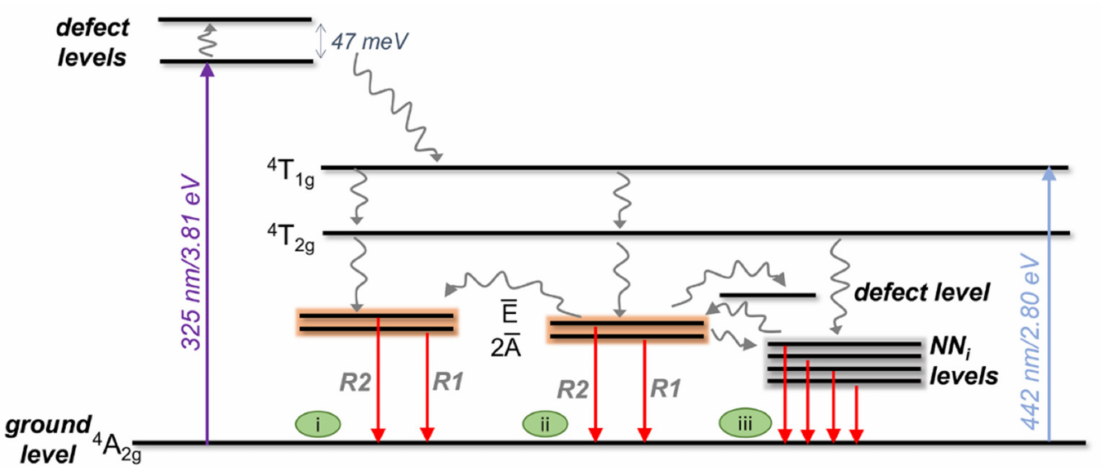
Figure 10. Schematic representation of the mechanism for the population/depopulation processes when ZGGO:Cr is excited under 325 nm and 442 nm. The curved arrows denote non-radiative processes, while the straight red ones correspond to radiative ones. The orange rectangles involving the E and 2 A states illustrate the R2/R1 thermalisation process. i, ii, and iii indicate different Cr 3+ centres present in the sample. The diagram is not to scale and it was assumed that the ground level was at the same energy location for all the Cr 3+ optical